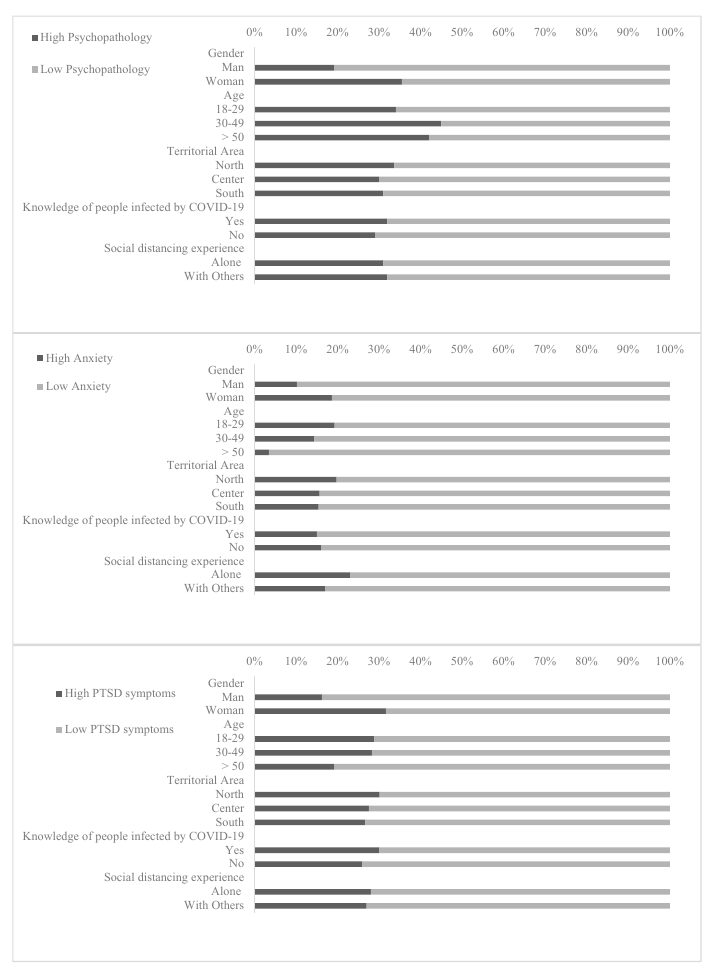
Figure 2. The prevalence of psychopathological symptomatology, state of anxiety, and PTSD, stratified by gender, age, territorial areas, knowledge of people affected by COVID-19, and loneliness in social distancing experience.